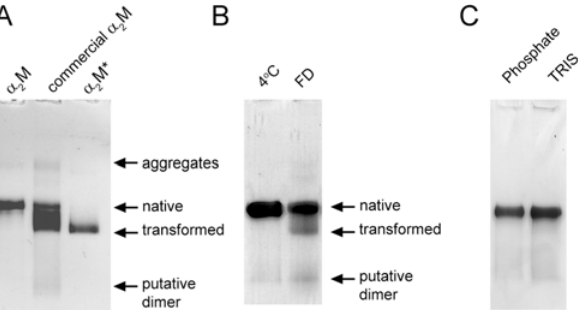
Fig 6. The effect of lyophilization from Tris buffer on purified α 2 M. Images of native PAGE (3 – 8% Tris- acetate) gels showing the migration of (A) reconstituted α 2 M that had been lyophilized from 20 mM Tris, 130 mM glycine, 80 mM trehalose, pH 8.0 and (B) α 2 M stored in solution at 4°C in 20 mM Tris, pH 8.0 for 2 months or following reconstitution after it had been lyophilized from 20 mM Tris, pH 8.0 and stored at -20°C for 7 days. As references, the positions of native and transformed α 2 M are also shown in (A). (C) Matched α 2 M samples in 20 mM phosphate, pH 7.4 or 20 mM Tris, pH 8.0 stored at 4°C for 2 months. Both samples contained 0.02% (w/v) sodium